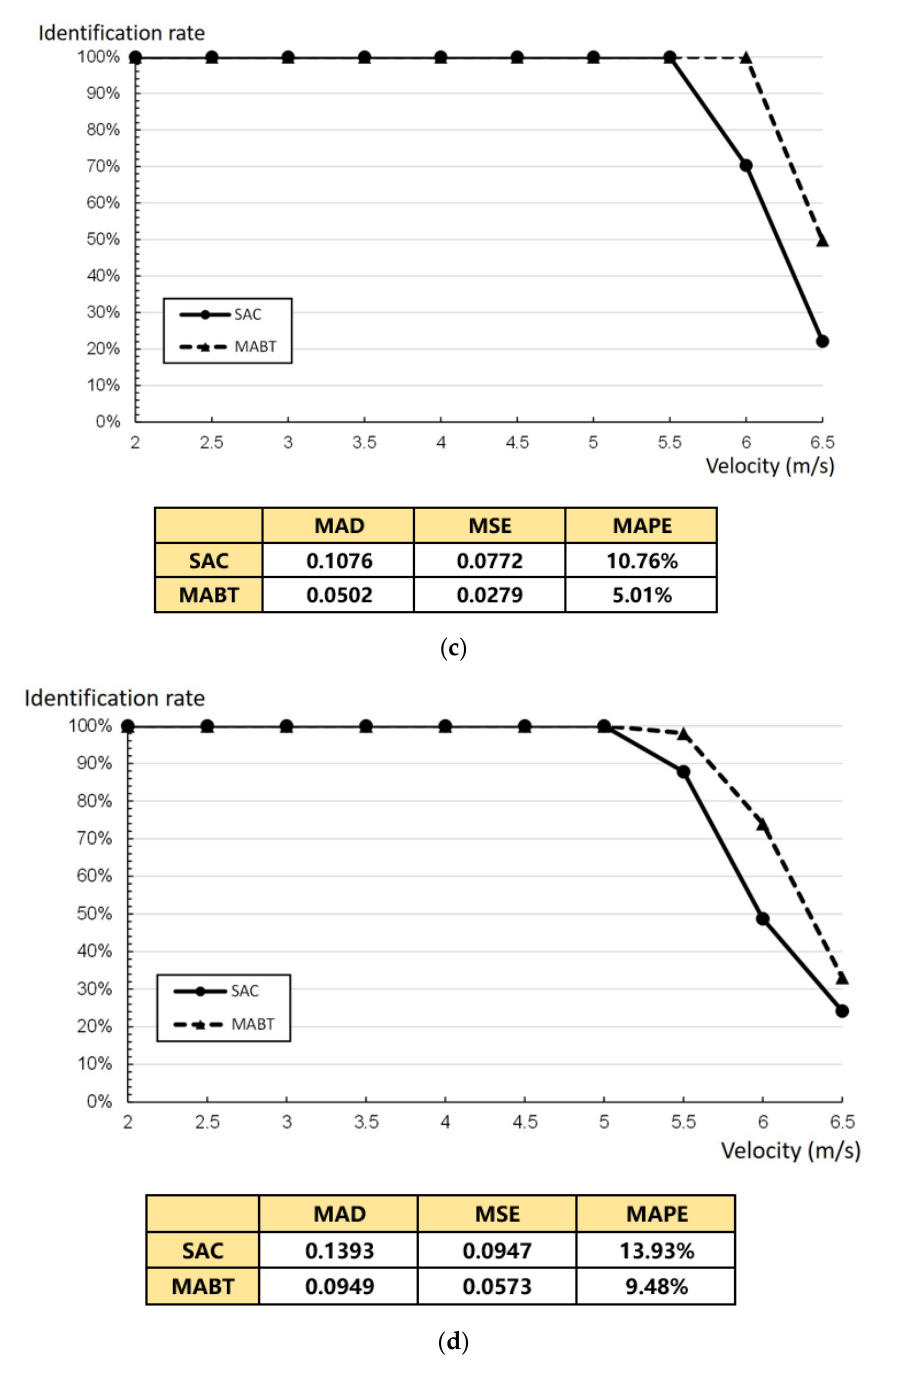
Figure 13. Average distance between tags: ( a ) fixed distance with one tag/column; ( b ) variable distance with one tag/column; ( c ) fixed distance with two tags/column; and ( d ) variable distance with two tags/column.